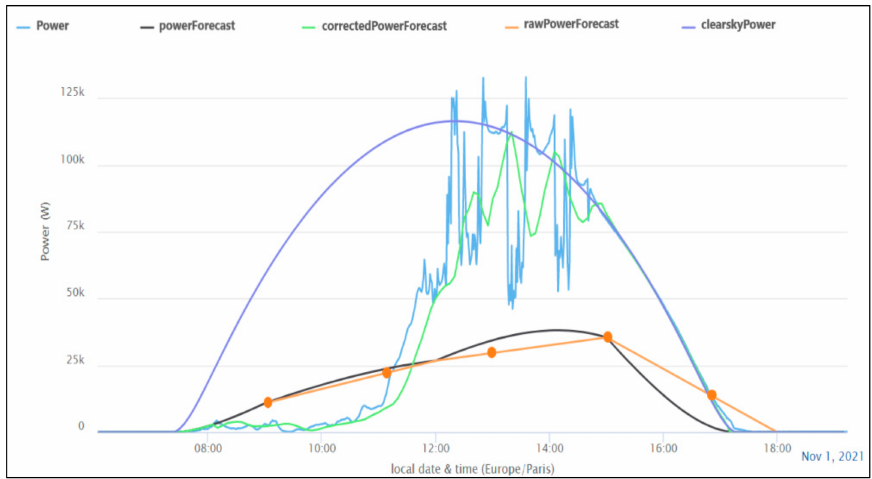
Figure 2. Illustration of the computation of the available